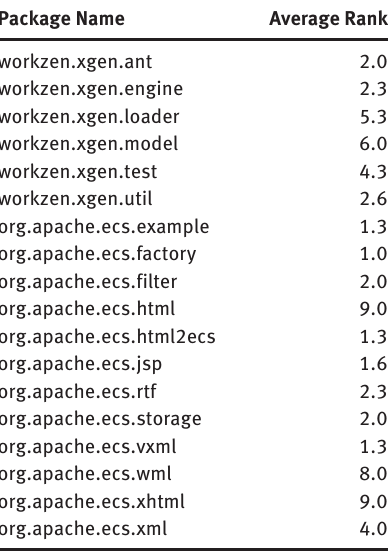
Table 8. Average Rank for the Effort